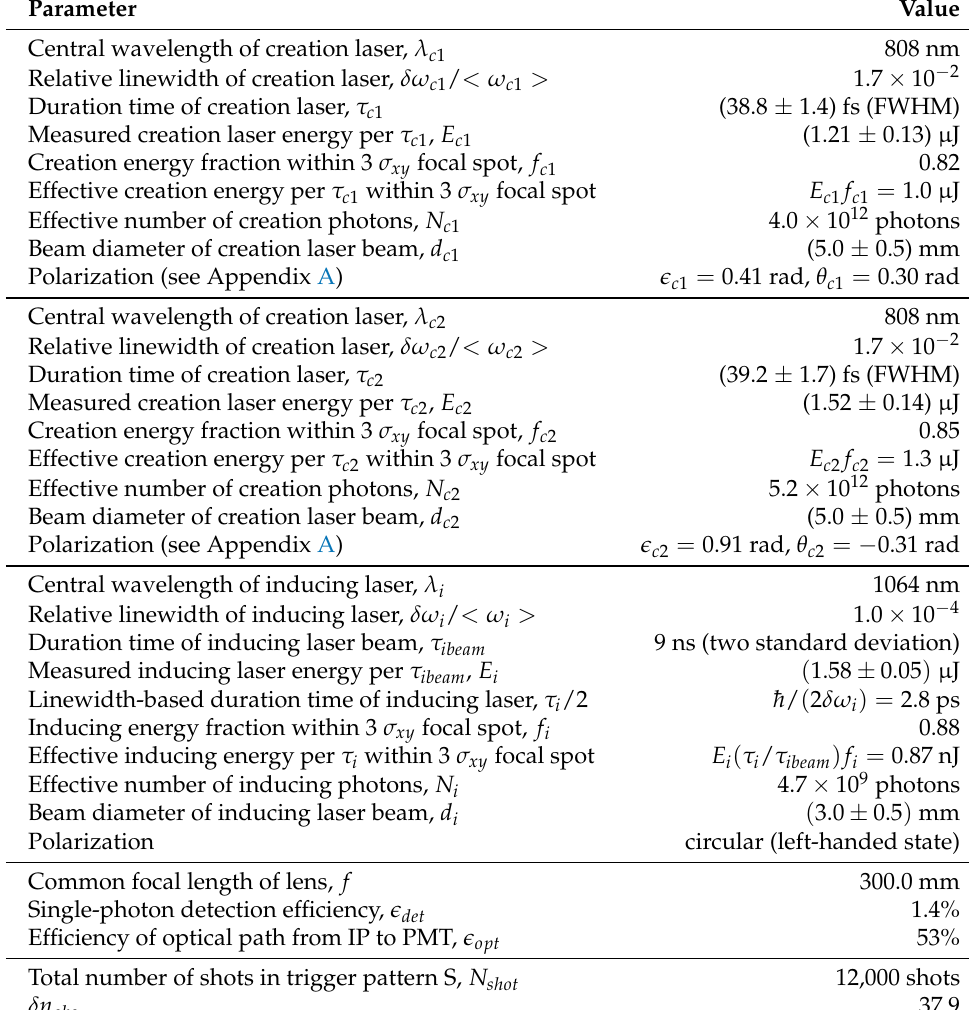
Table 1. Experimental parameters used to obtain the upper